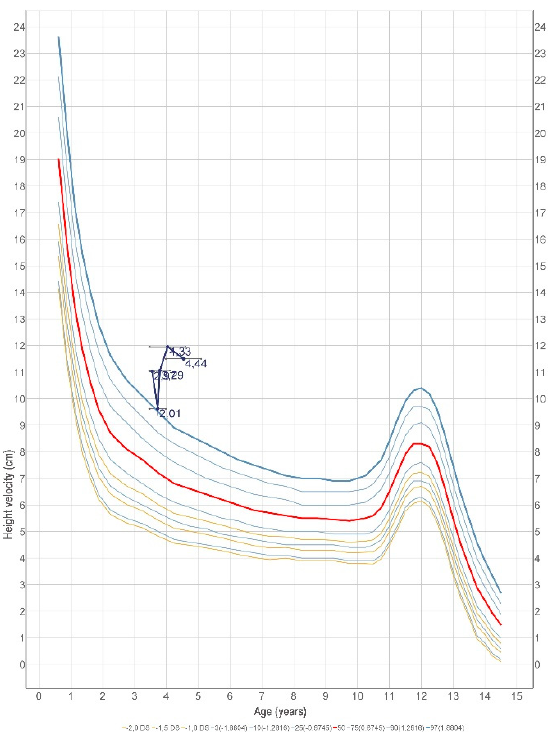
Figure 4. Growth velocity over the same period.